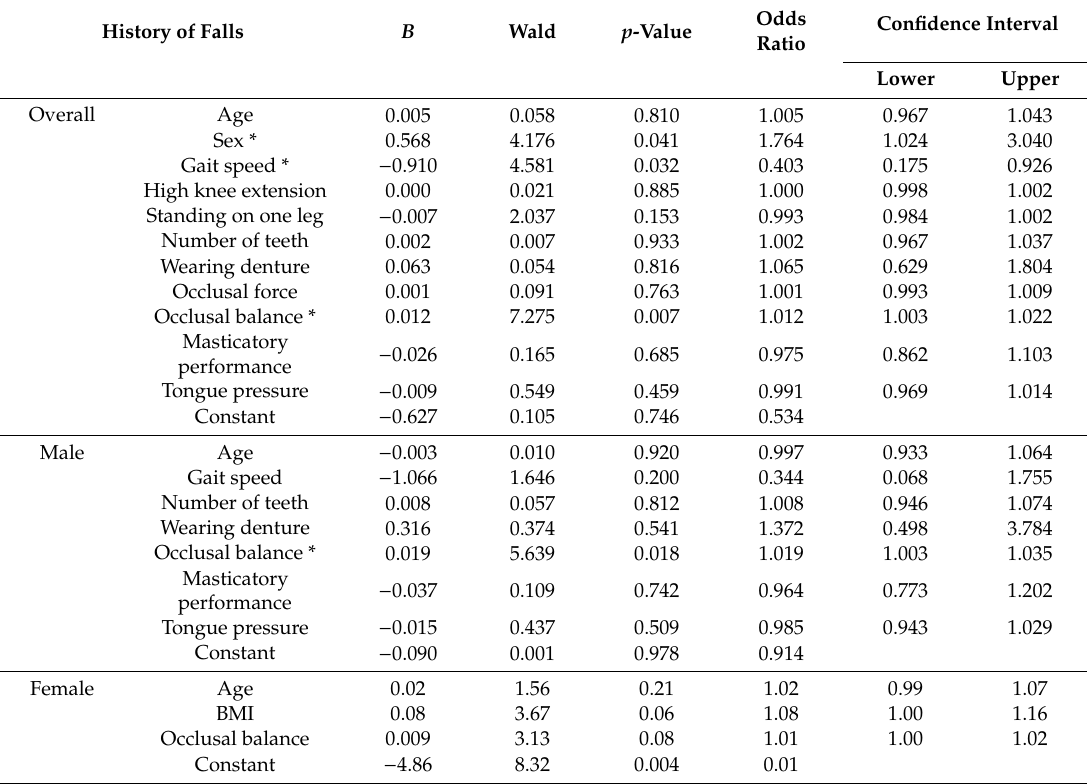
Table 5. Factors a ff ecting fall